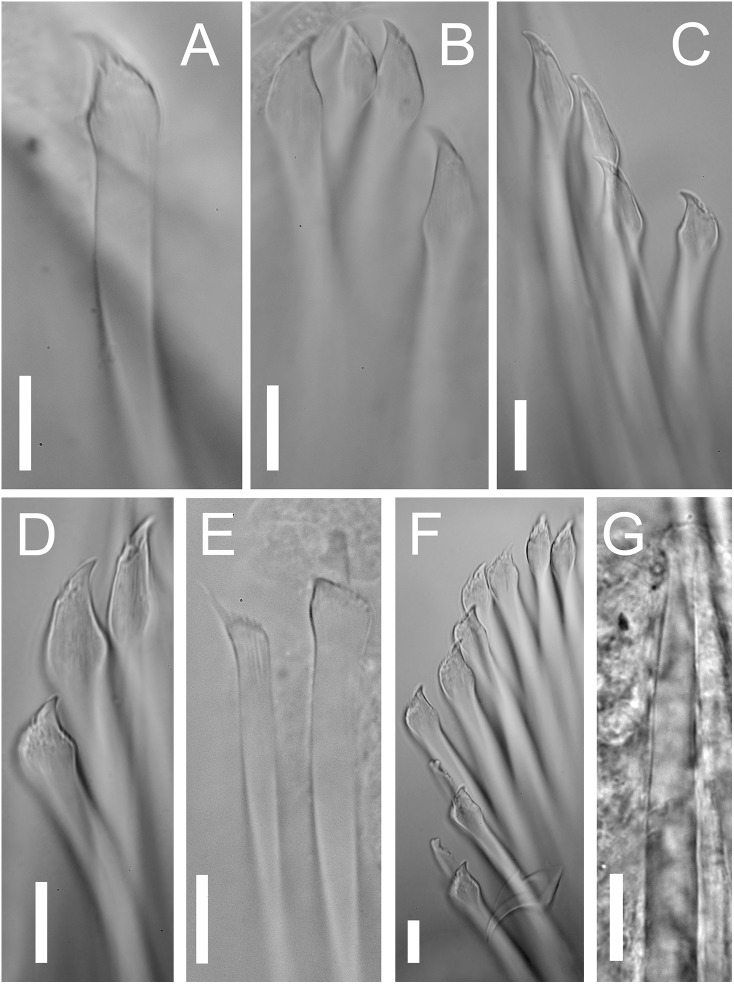
Proceraea exoryxae sp. nov. morphology of chaetae and aciculae.(A) Inferior-most simple chaeta, chaetiger 1 [MNCN 16.01/17717]. (B) Simple chaetae, chaetiger 3 [MNCN 16.01/17717]. (C) Simple chaetae, chaetiger 4 [MNCN 16.01/17719]. (D) Simple chaetae, chaetiger 5 [MNCN 16.01/17719]. (E) Simple and compound chaetae, chaetiger 10 [MNCN 16.01/17719]. (F) Bayonet chaeta and compound chaeta, chaetiger 9 [MNCN 16.01/17717]. (G) Mid-body acicula [MNCN 16.01/17723]. Scale bars A–G = 0.1 mm.